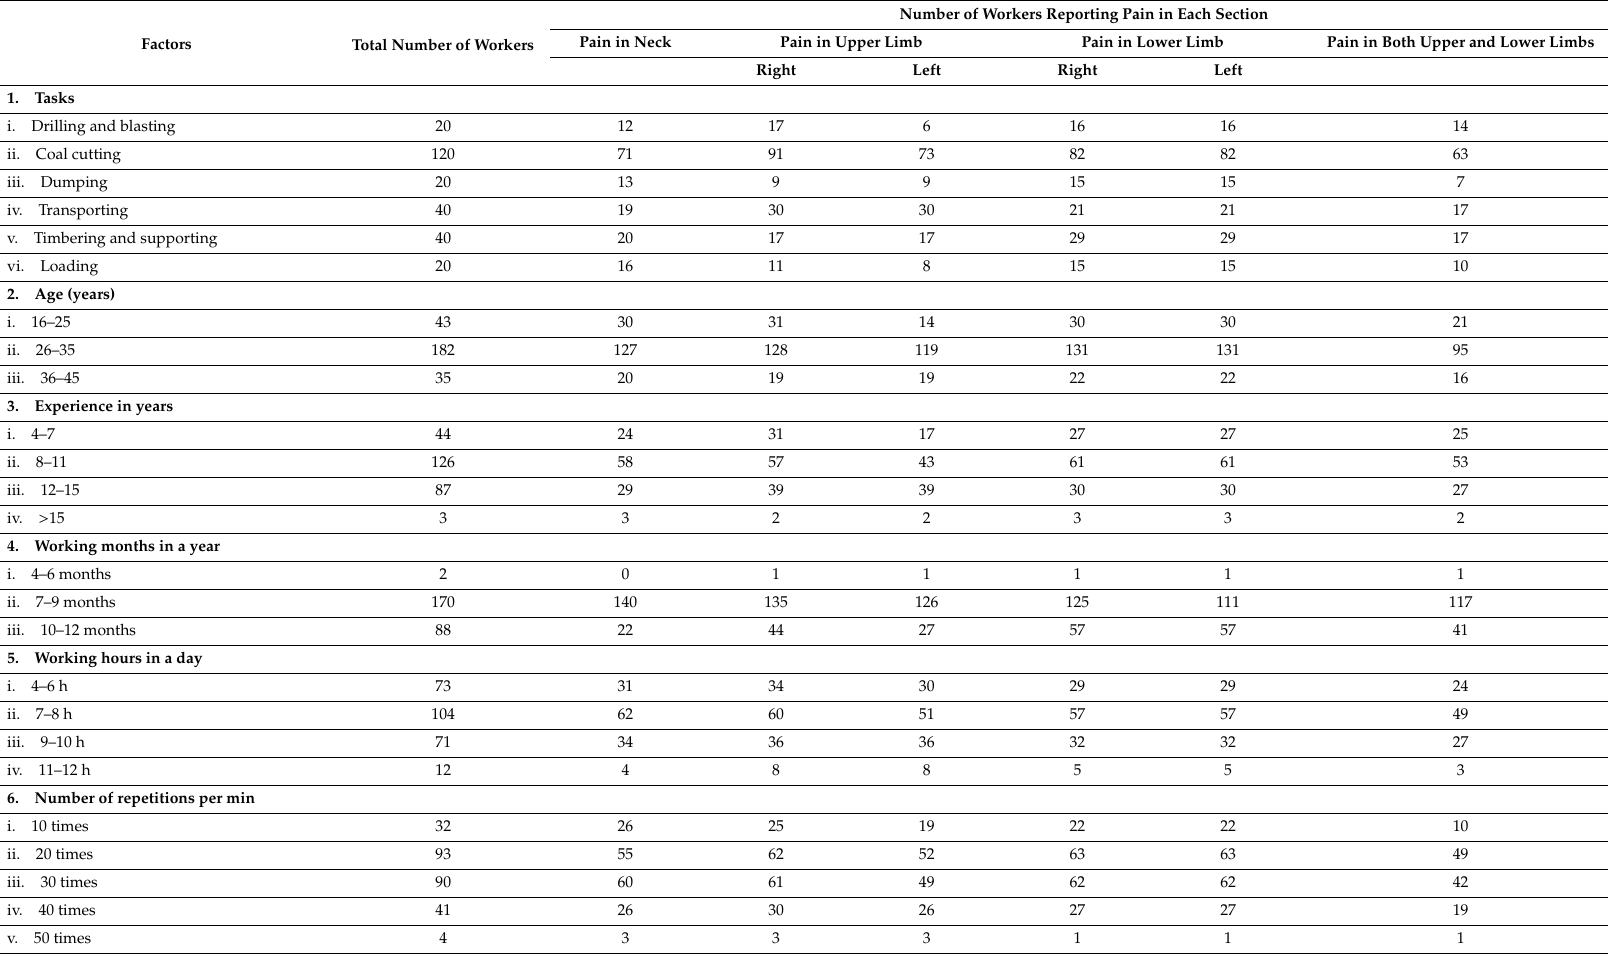
Table 3. Reported related musculoskeletal disorder (MSD) pain from personal / occupational factors. Number of Workers Reporting Pain in Each Section Pain in Neck Pain in Upper Limb Pain in Lower Limb Pain in Both Upper and Lower Limbs Factors Total Number of Workers Right Left Right